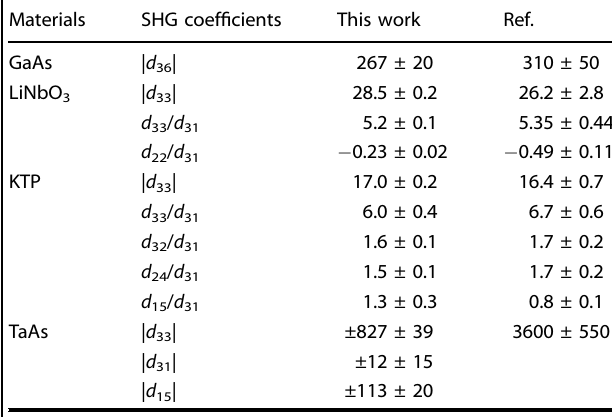
Fig. 6 Linear and nonlinear optical responses of KTP (100). a Crystal structure and experimental orientation. b The effective complex refractive indices at ω frequency as a function of incident angle ( θ i ). c and d p - and s -polarized second harmonic responses as a function of azimuthal angle ( φ ) at various incident angles ( θ i ). e Comparison of the correct ratios of nonlinear coef fi cients (pale green background) as against other forced approximations (pale orange background). Iso, and KS, respectively, represent isotropic symmetry and Kleinman symmetry approximations, respectively. Iso ð ε ii Þ indicates that the component ε ii was assumed in all directions under the isotropic approximation, where i is the direction index. Table 1. Comparison of ratios of SHG coef fi cients from ♯ SHAARP and